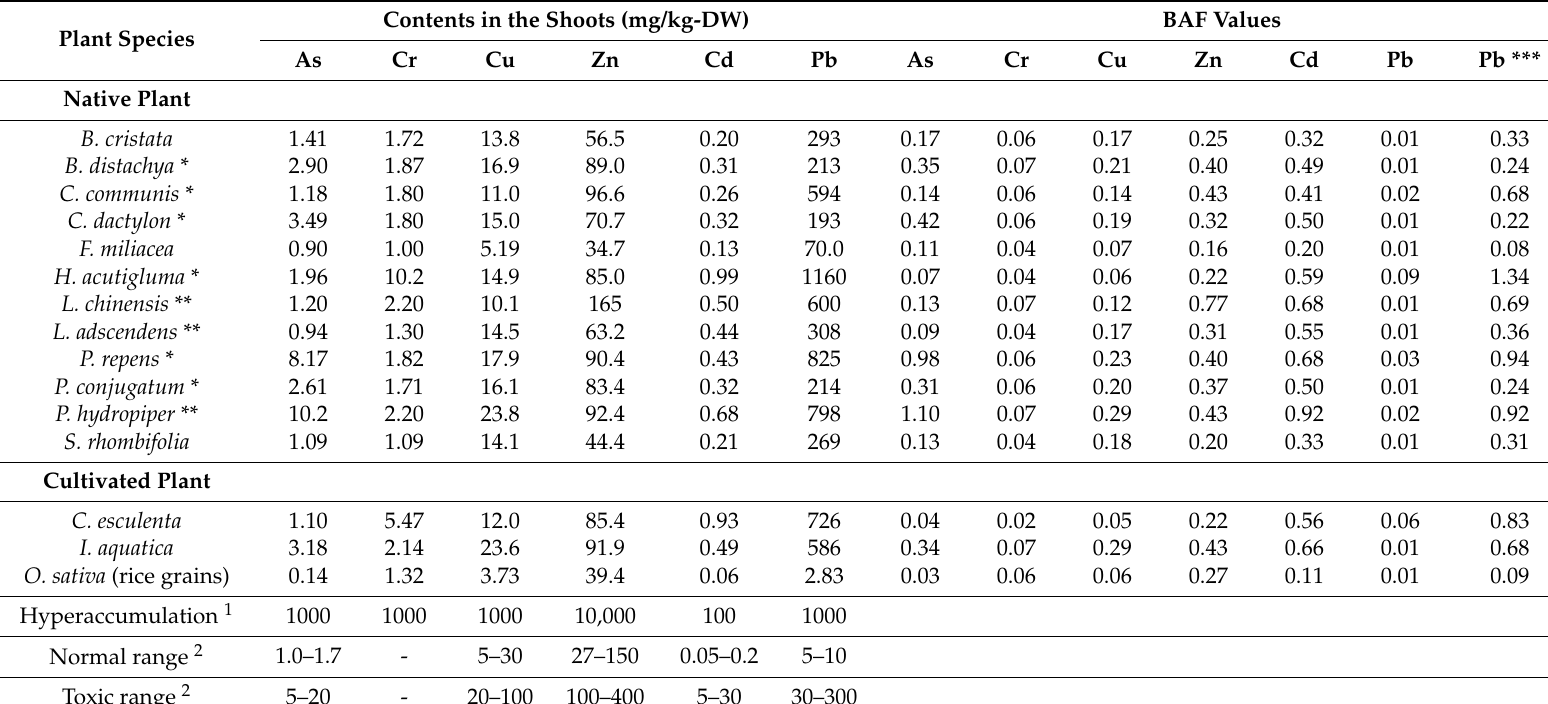
Table 4. BAF values, contents of As and heavy metals in the shoots of native and cultivated plants collected at the Dong Mai Pb recycling area. Plant